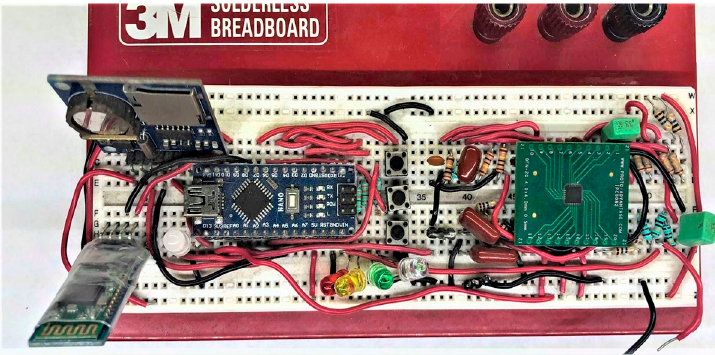
Figure 5. ECG monitor breadboard circuit with interchangeable AD8232 and AD8233 microchip adapters.